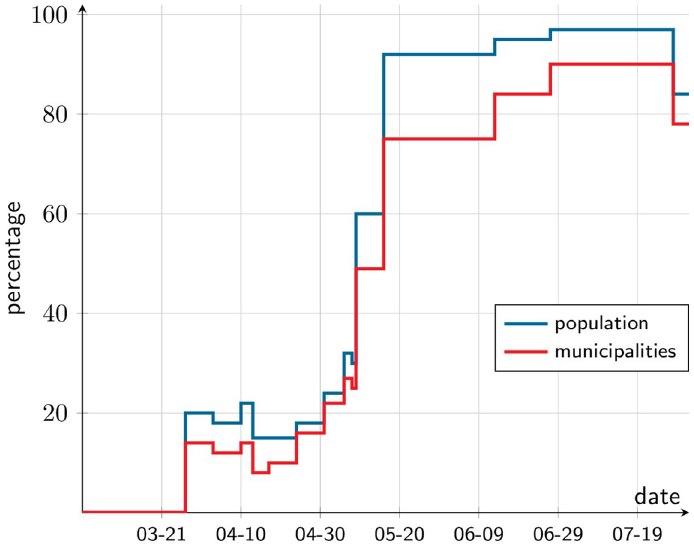
Fig 1. Chile’s targeted lockdown policy. Percentage of inhabitants (blue) and municipalities (red) under lockdown in the SMR. From March 1 till August 1, 2020.